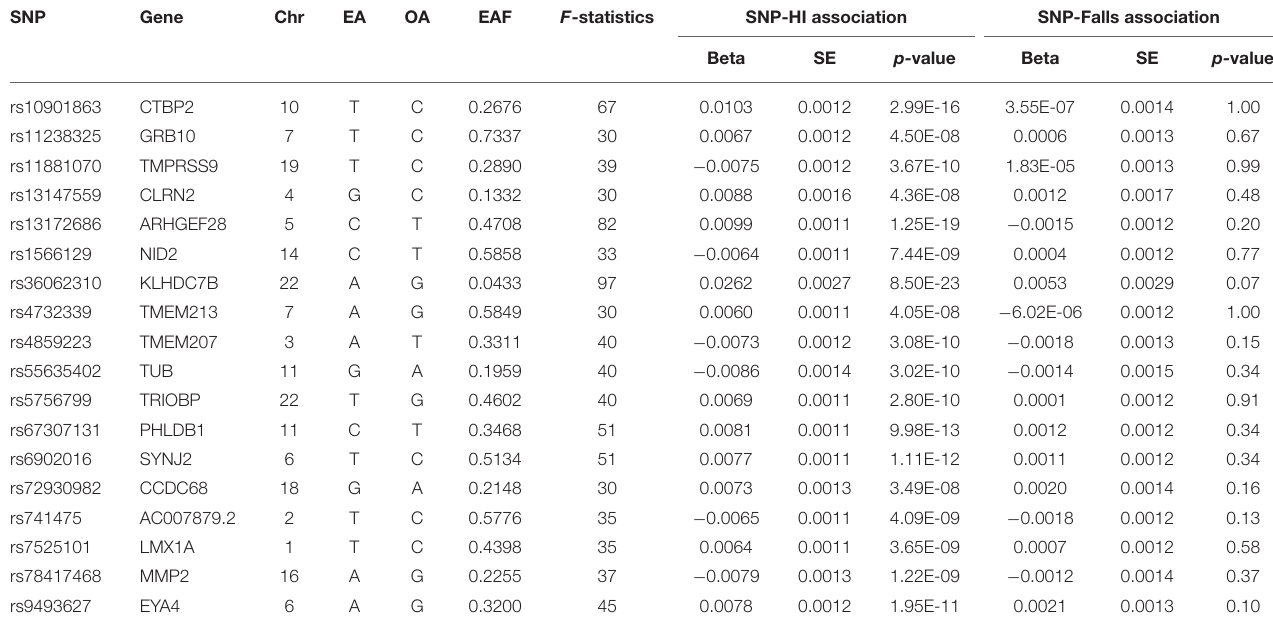
TABLE 1 | The characteristics of eighteen SNPs and their genetic associations with HI and falls. SNP Gene